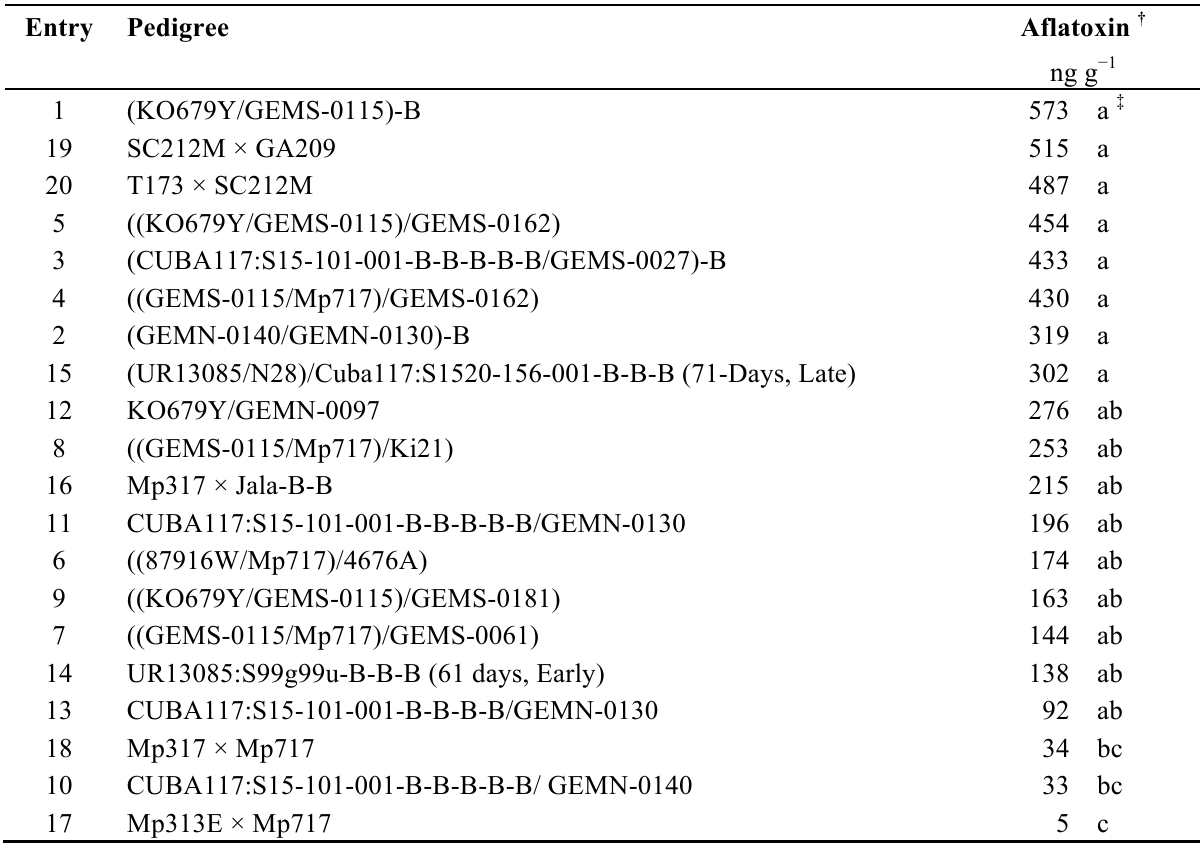
Table 4. Aflatoxin evaluation of corn hybrids and breeding crosses in